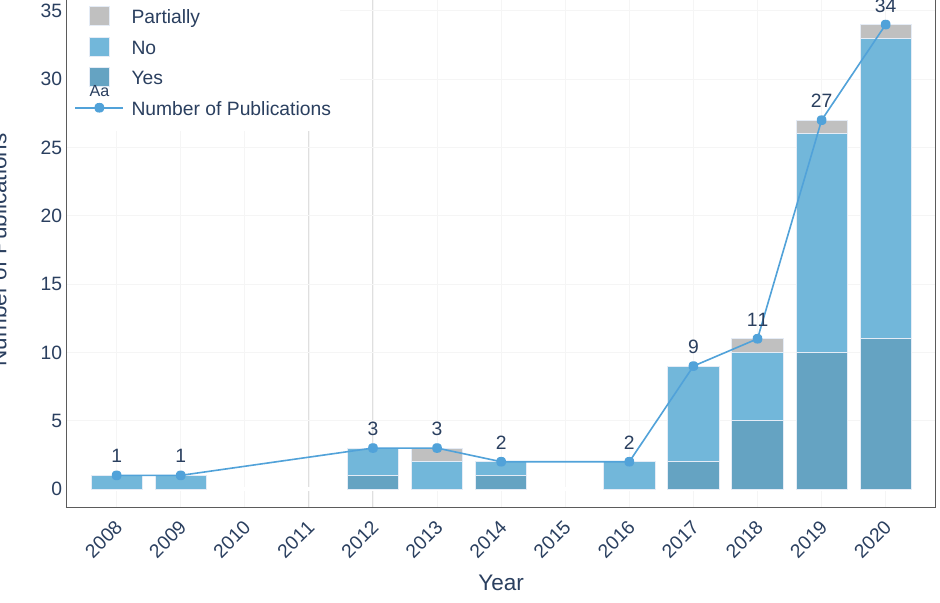
Figure 8. Data availability over the